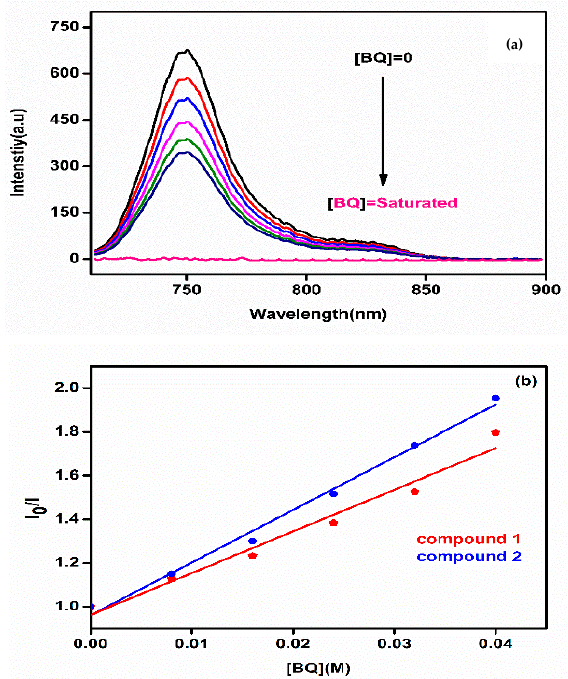
Figure 4. ( a ) Fluorescence emission spectral changes of 3b (1 × 10 − 5 M) by the addition of different concentrations of BQ in DMF (Excitation wavelength = 700 nm) and ( b ) Stern–Volmer plots for 1,4-benzoquinone (BQ) quenching of introduced metal-free and zinc(II) phthalocyanines. [MPc] = 1 × 10 − 5 M in DMF. [BQ] = 0, 0.008, 0.016, 0.024, 0.032 0.04 M.